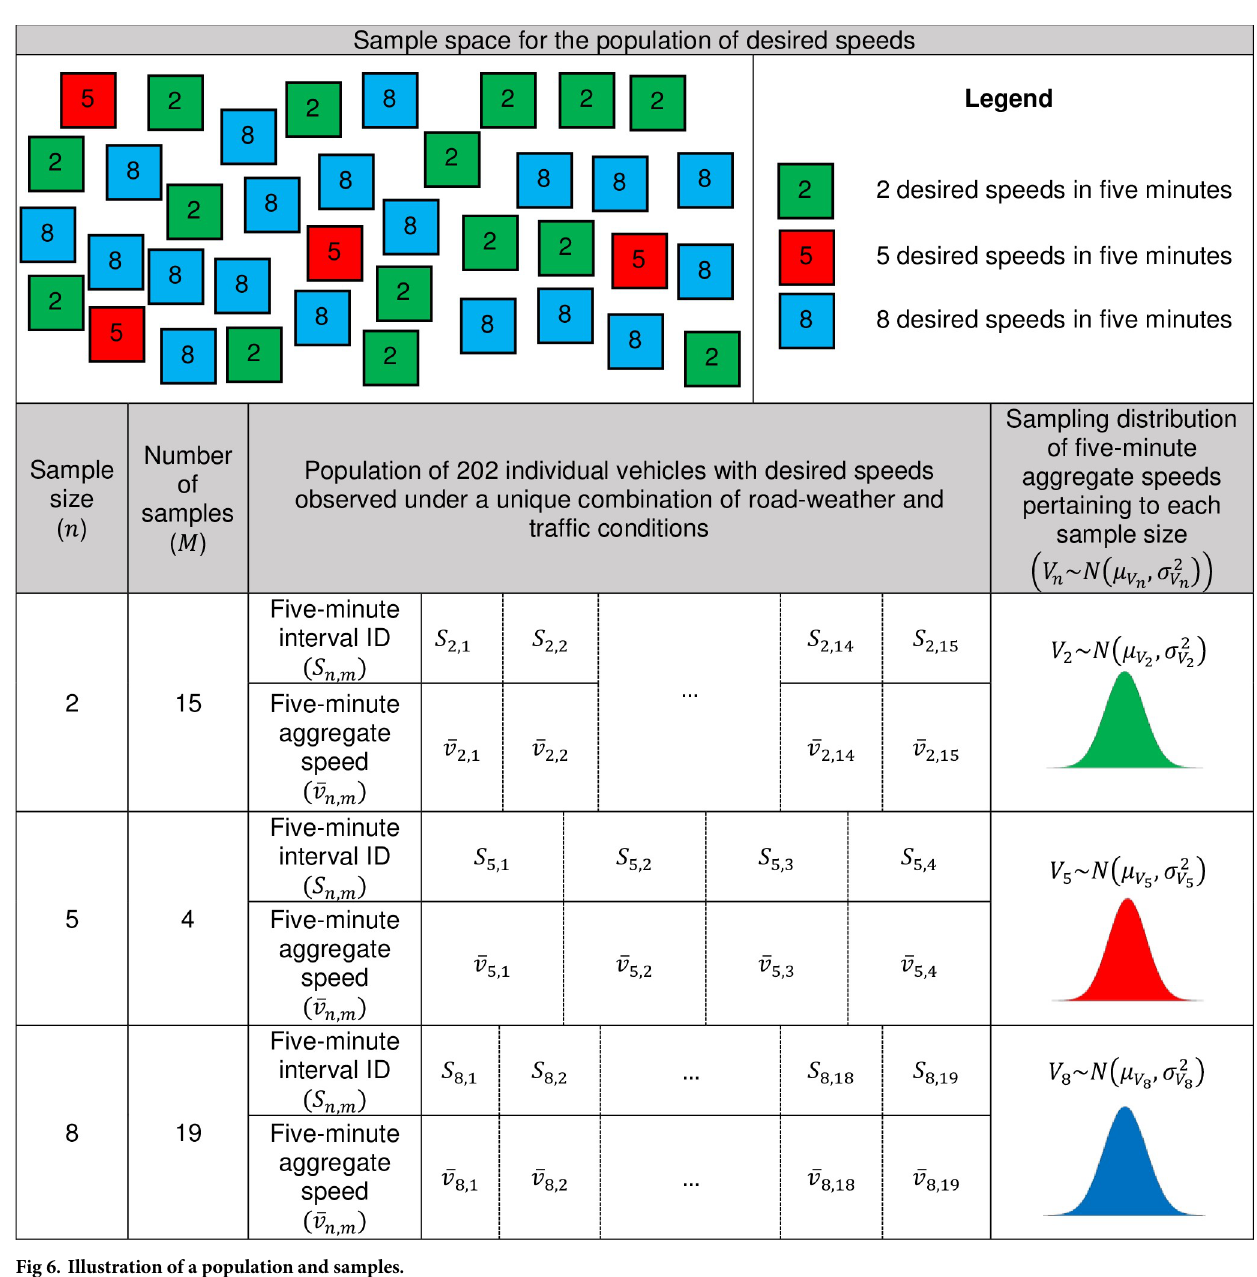
traffic conditions, enclosed in 38 five-minute intervals belonging to three unique sample sizes ( k = 3). Each five-minute aggregate interval in the population is assigned with a unique sample ID denoted by S , where n denotes the sample size and m (1 � m � M ) denotes the sample n , m number pertaining to the sample size n . The number of five-minute intervals recorded with identical five-minute volumes is denoted by M ( M 2 Z + ). The five-minute aggregate speed in each five-minute interval represents the sample mean speed and is denoted by � v . The five- n ; m minute aggregate intervals observed with identical number of vehicles are clustered together to produce sampling distributions of mean speed. Accordingly, V represents the sampling n